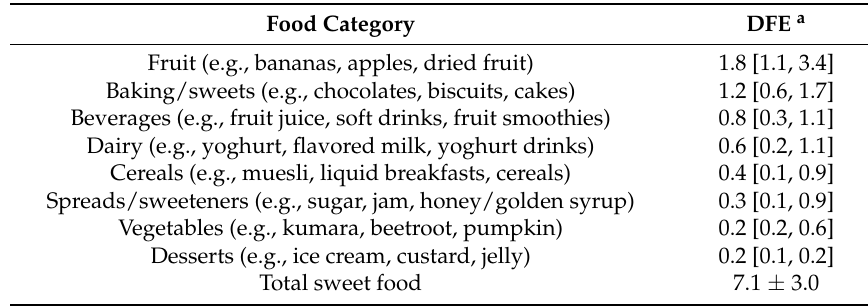
Table 4. Frequency of intake of sweet food